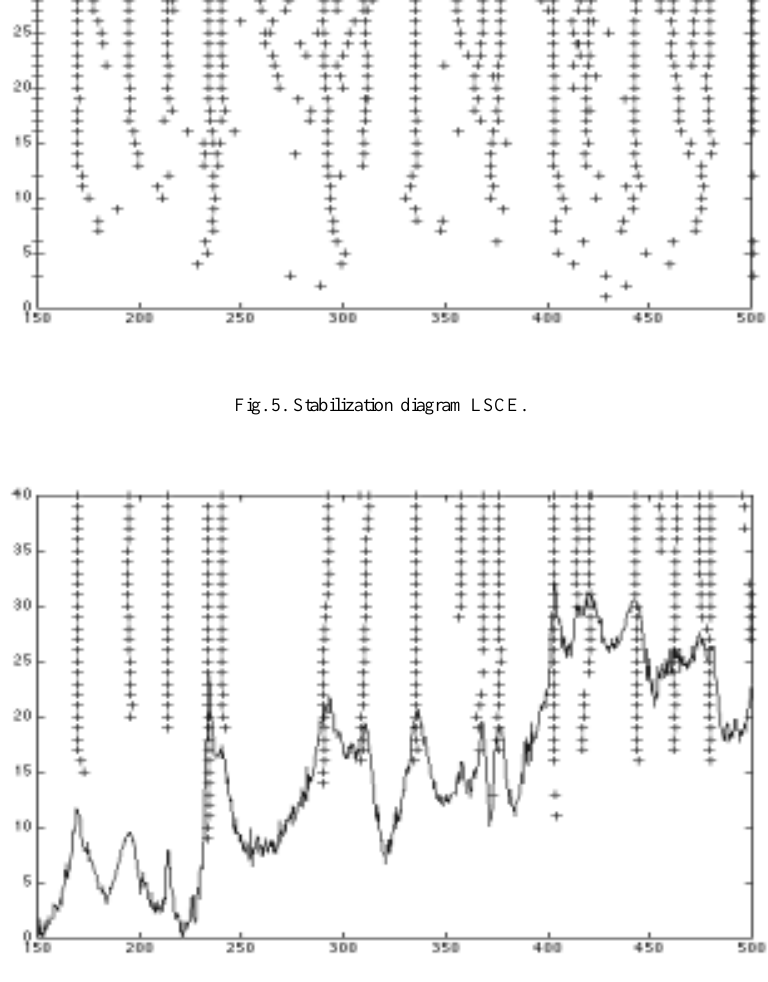
Fig. 6. Stabilization diagram